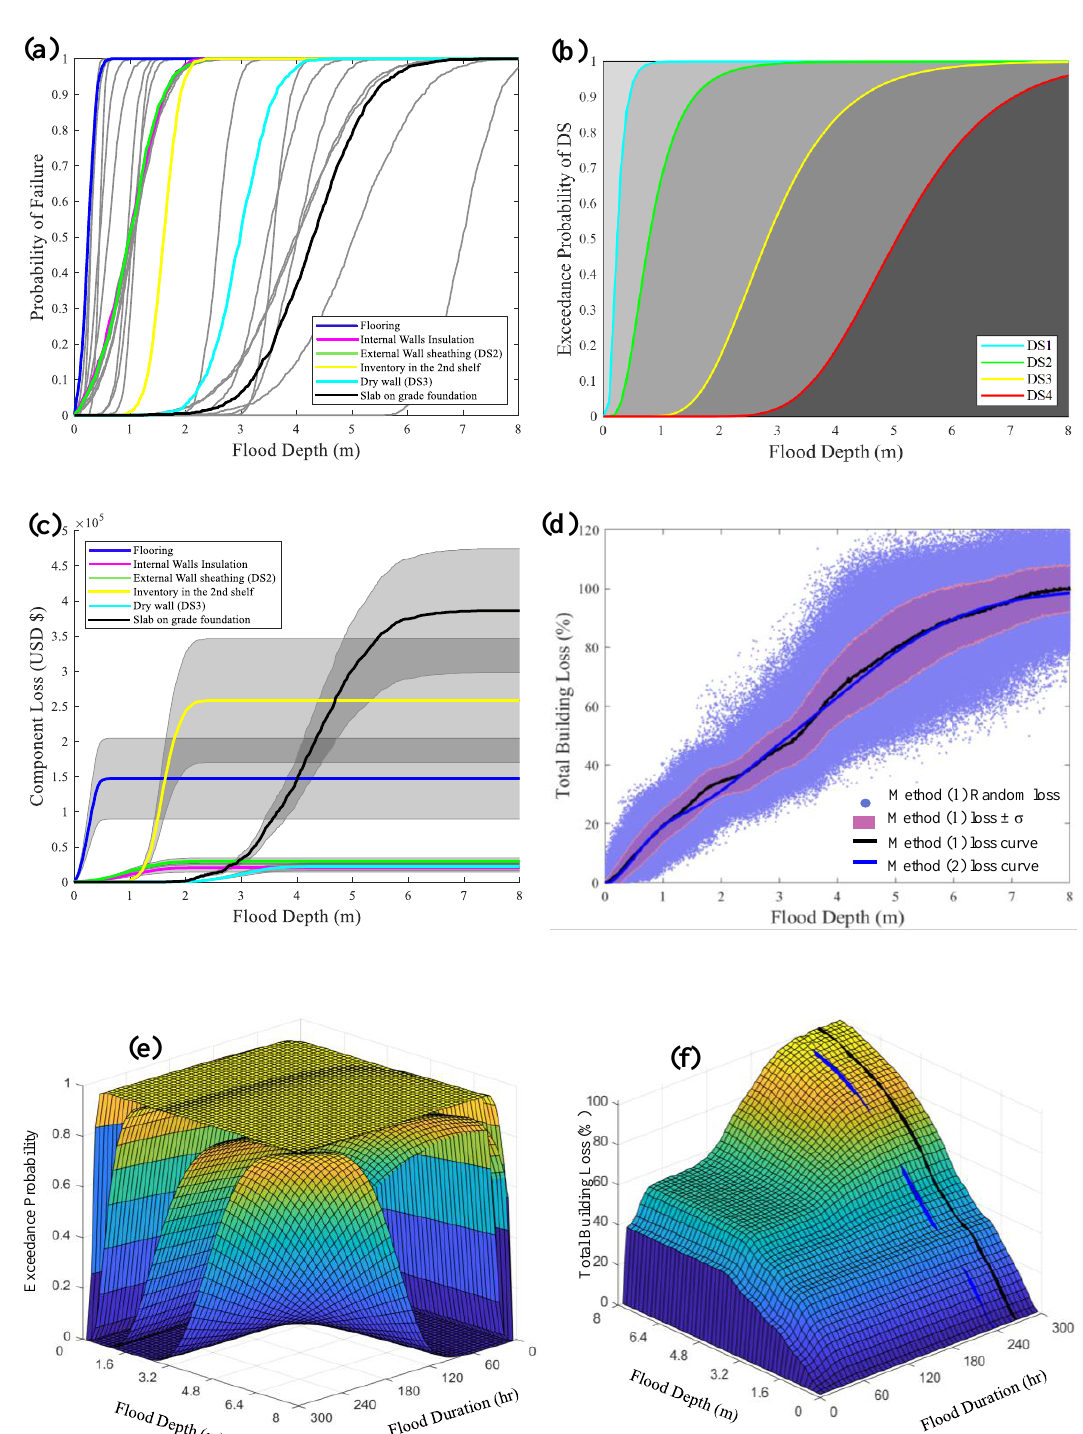
Figure A29. F15 archetype analysis results: ( a ) Component fragility curves; ( b ) Building fragility curves; ( c ) Selected components’ loss curves; ( d ) Building loss curves; ( e ) Building fragility surfaces; ( f ) Building loss surface.